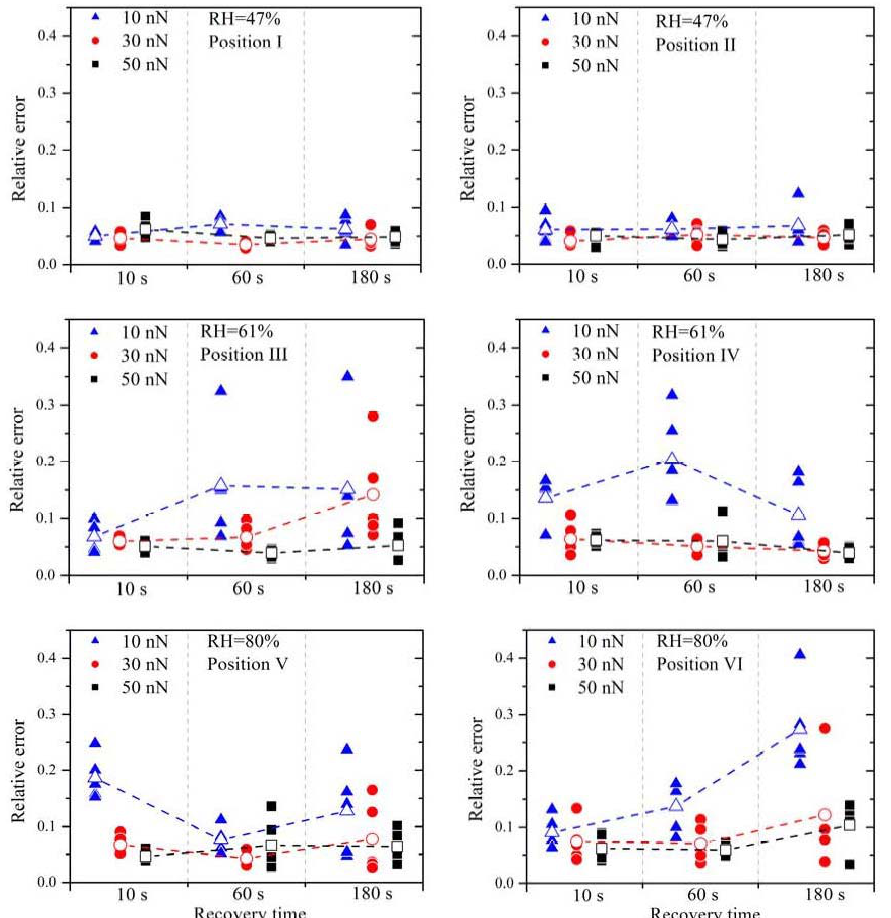
Figure 3. Relative errors, calculated from several measurement series, are plotted as a function of the applied force between the tip, the relative humidity of the gas atmosphere, the tip position on the sample and the recovery time between the different measurements. The open symbols represent the arithmetic mean of the five